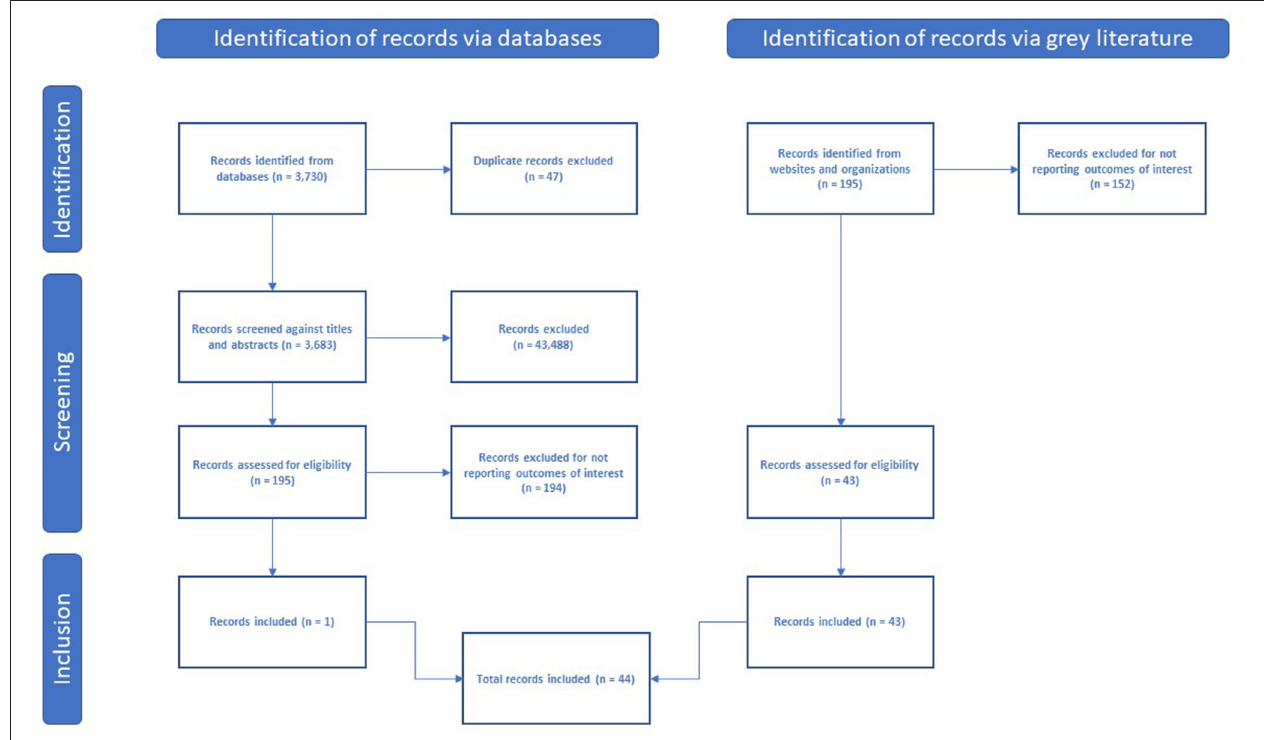
FIGURE 1 | PRISMA